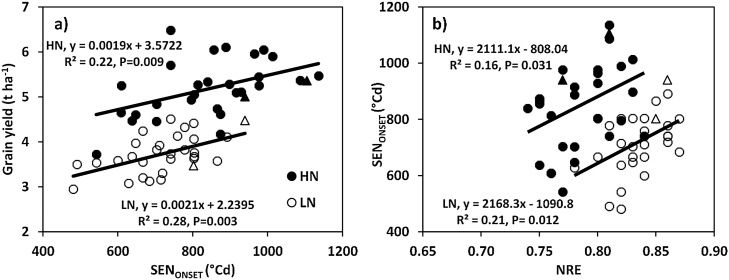
Linear regression of (a) grain yield (100% DM) on flag-leaf onset of senescence (SENONSET) (b) N-remobilization efficiency (NRE) on SENONSET under high N (HN) and low N (LN) conditions for 30 Indian wheat cultivars. (Values are mean of 2013–14 and 2015–16) (bread wheat cultivar HN ●; durum wheat cultivar HN▲; bread wheat cultivar LN ○; durum wheat cultivar LN △).